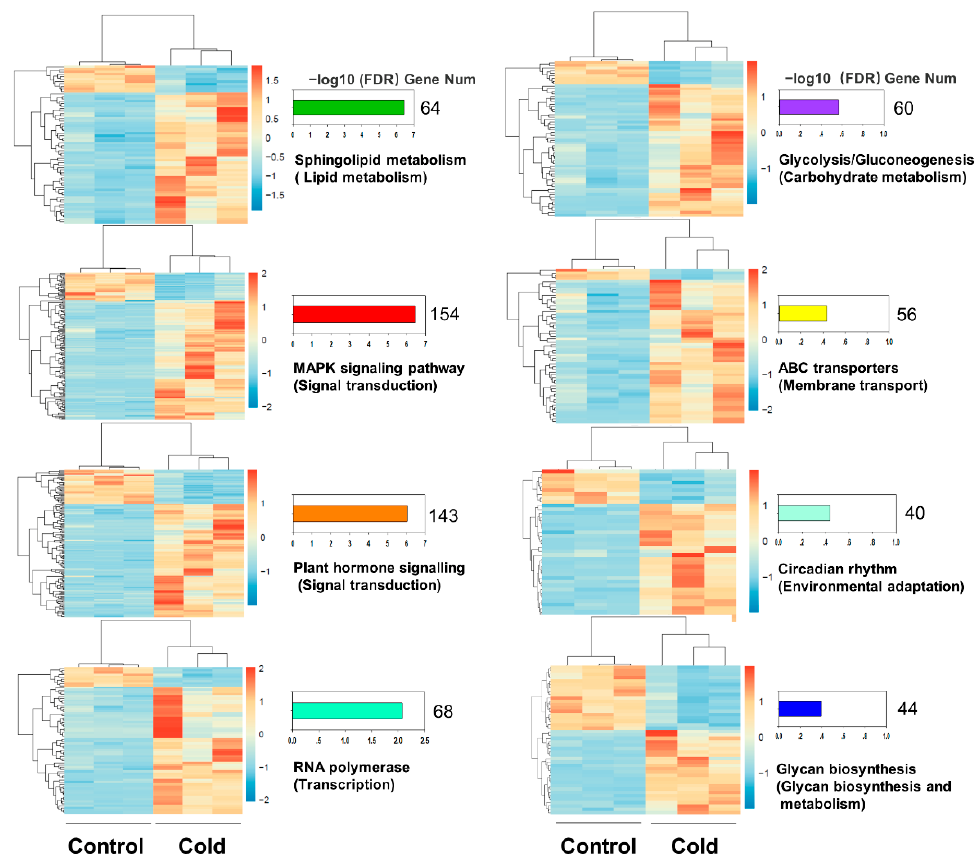
Figure 3. Heatmap of mainly enriched pathways. Bar graph of − log10 transformed FDR values are shown.